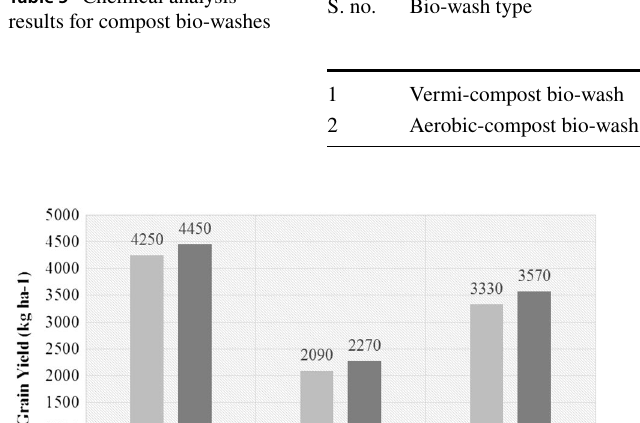
Vermi-compost Aerobic-compost Table 5 Chemical analysis results for compost bio-washes